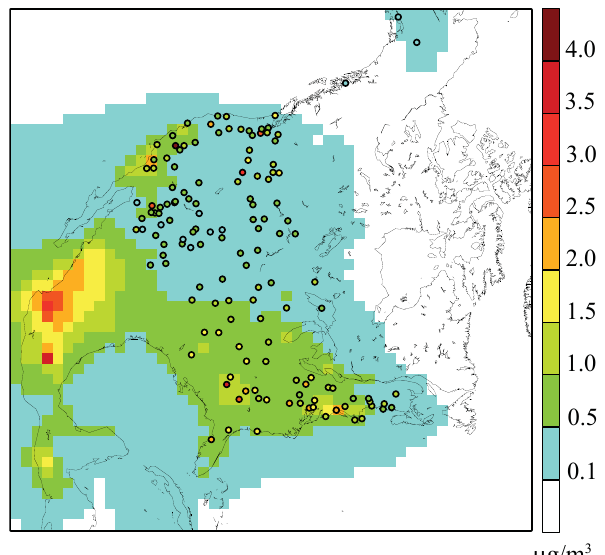
Fig. 6. Spatial distribution of simulated annual average concentra- tion (µgm − 3 ) of OAs (primary and secondary OAs) against mea- surements (circles) from sites in the IMPROVE network, for 2006.